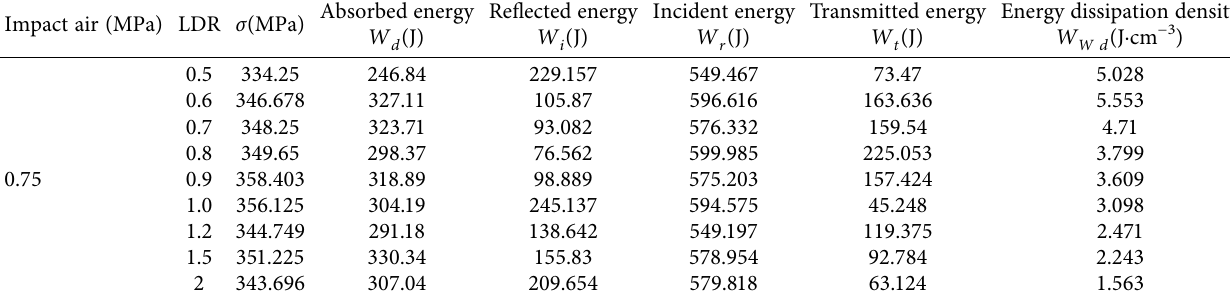
Table 1: Statistical distribution of specimens’